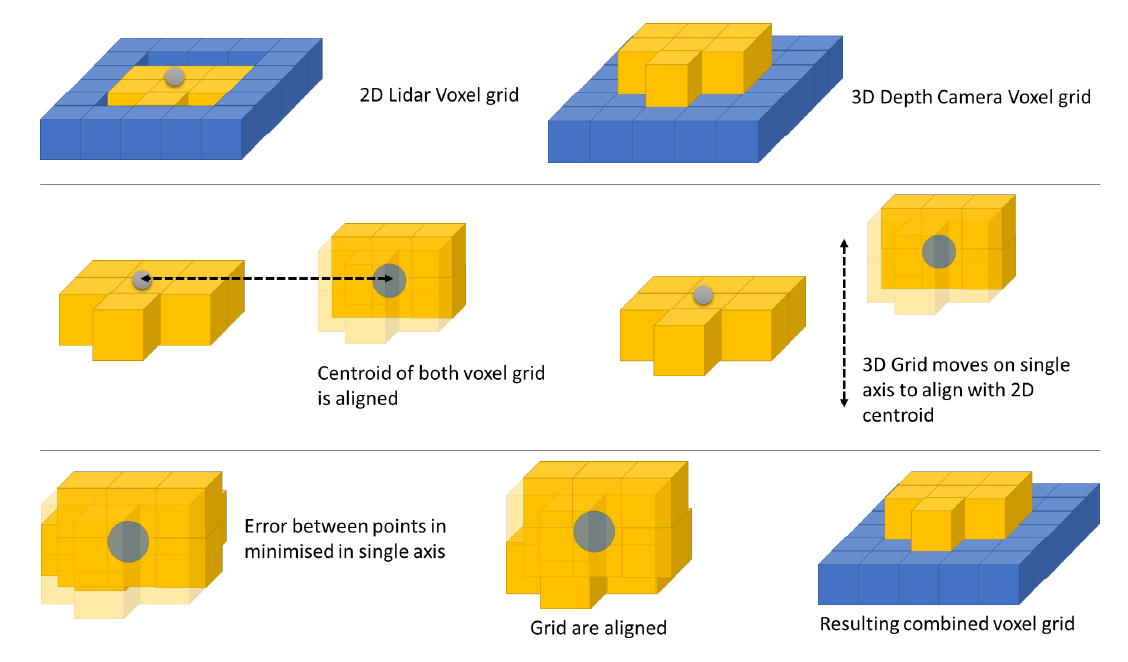
Figure 21. Figure for alignment between 2D and 3D